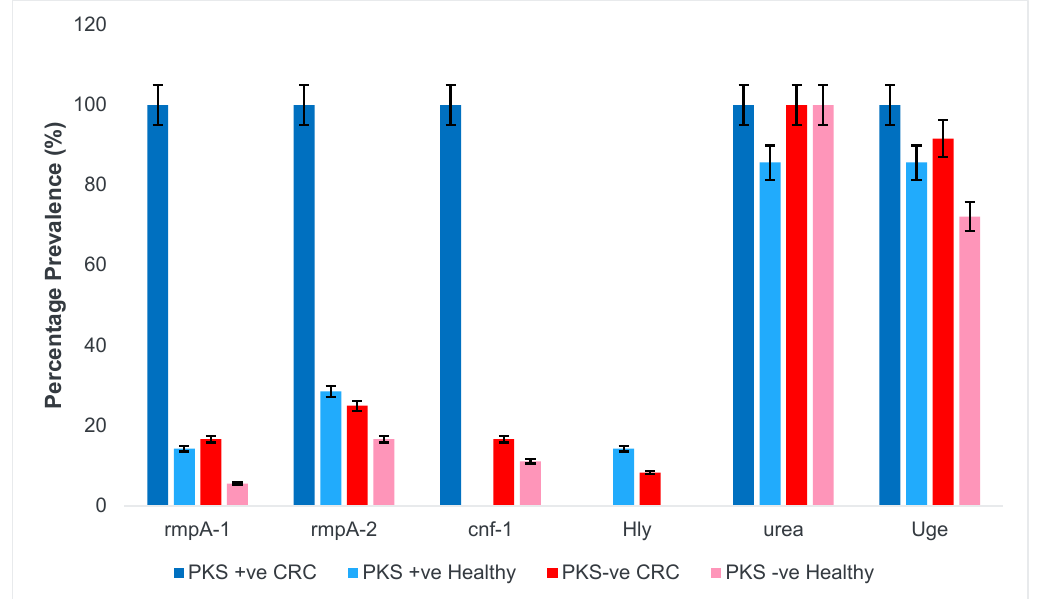
Figure 2. Prevalence of regulator of mucoid phenotype and accessory genes among K. pneumoniae isolates. Regulator of mucoid phenotype A ( rmpA1, rmpA2 ), Cytotoxic